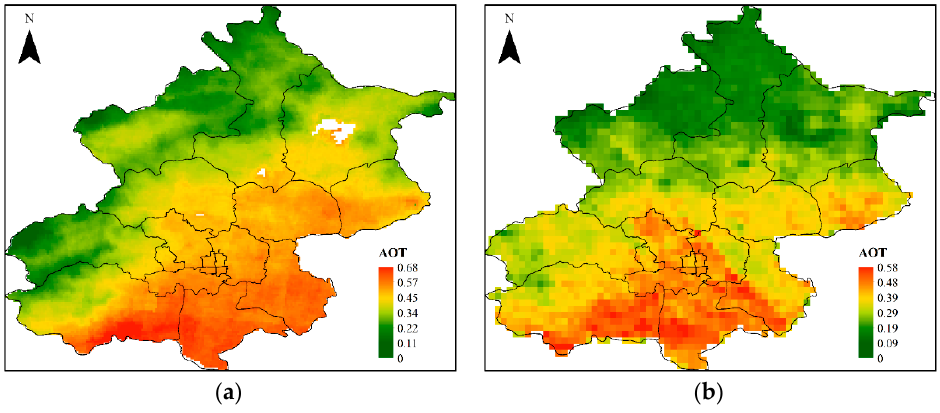
Figure 6. 2014 AOT distribution: ( a ) 1 km MAIAC AOT (left); ( b ) 3 km MOD-3K AOT (right).